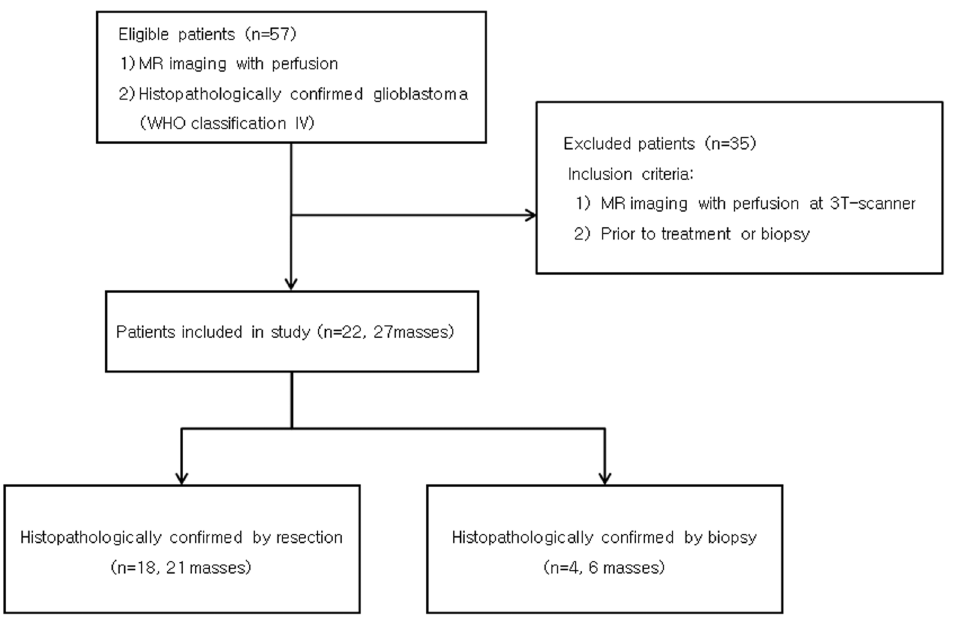
Figure 1. Flowchart of patient selection and inclusion criteria. MR=magnetic resonance; WHO=World Health Organization.